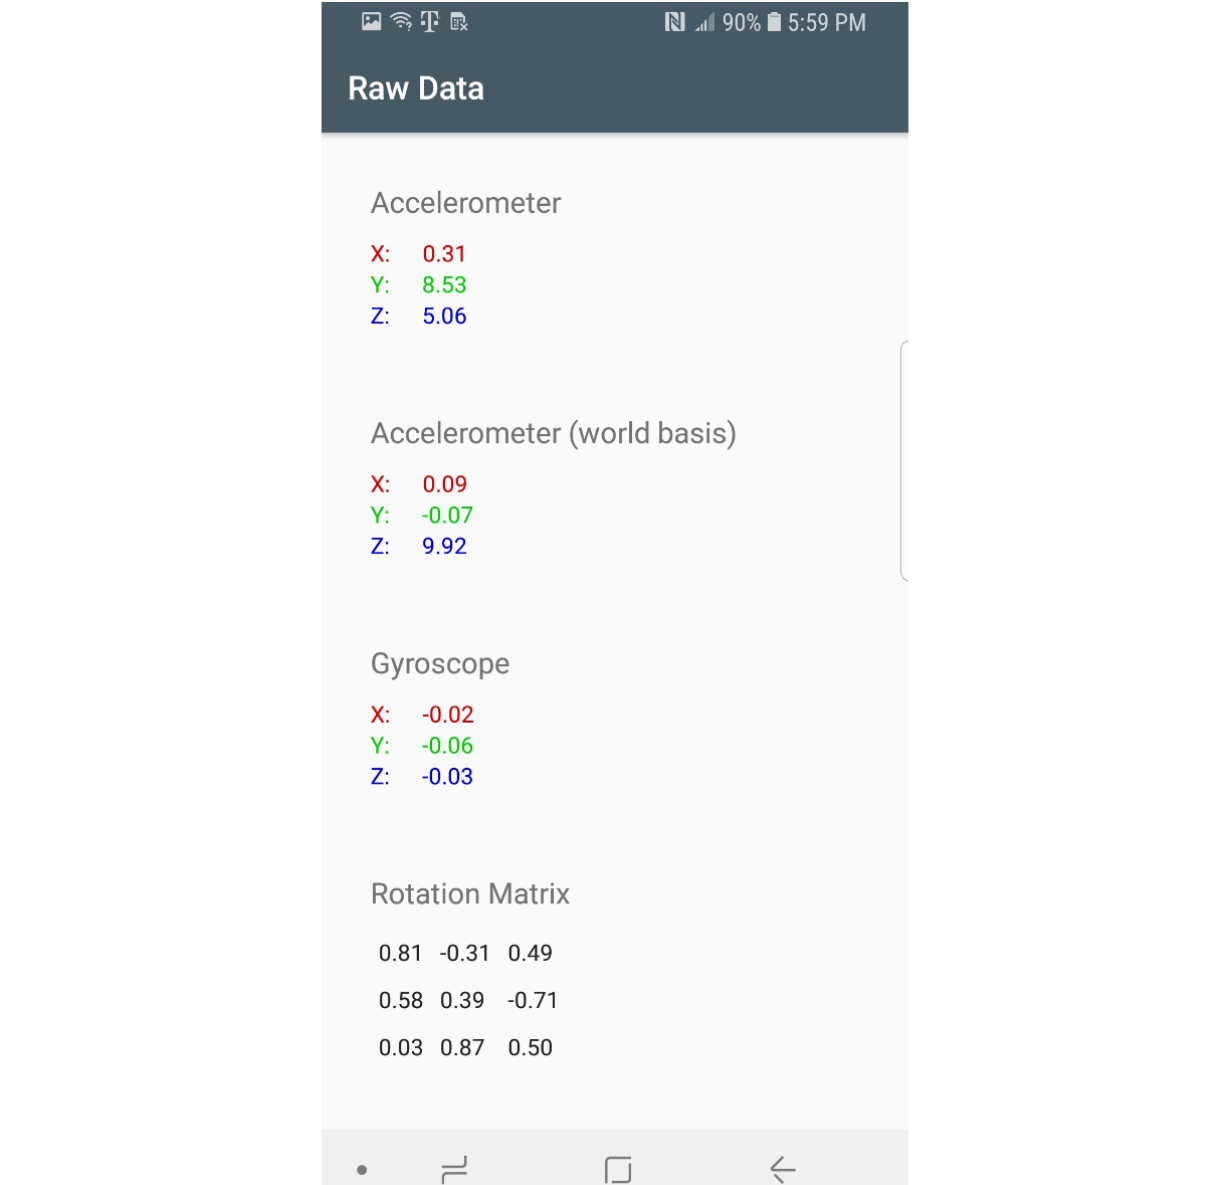
Figure 6. Sensor data